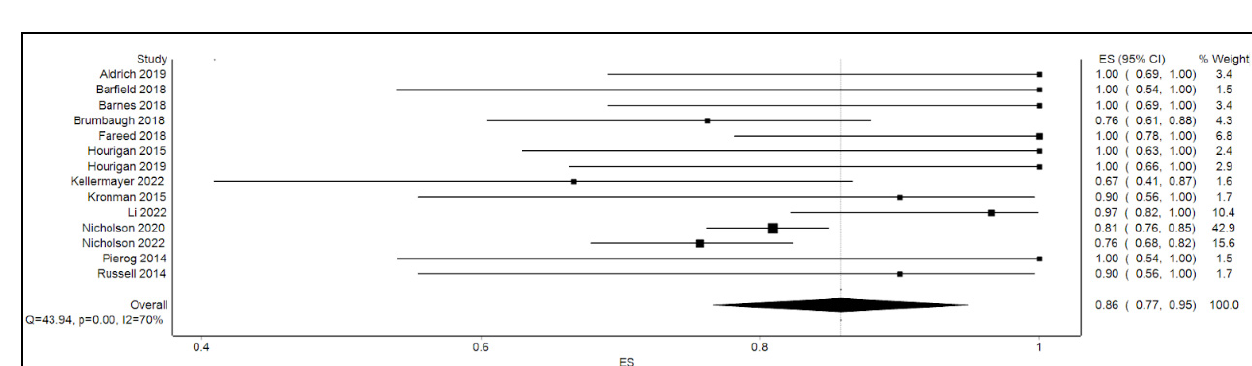
Figure 2. Forest plot displaying clinical success or efficacy of FMT.